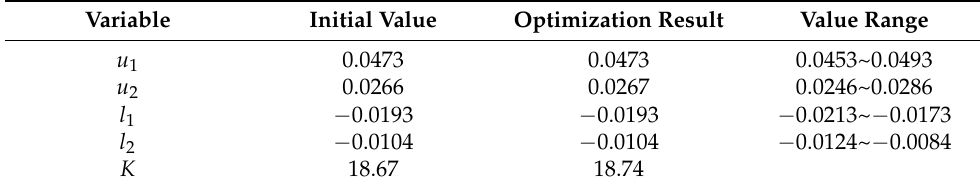
Table 6. Optimization results of airfoil 1 under condition A.